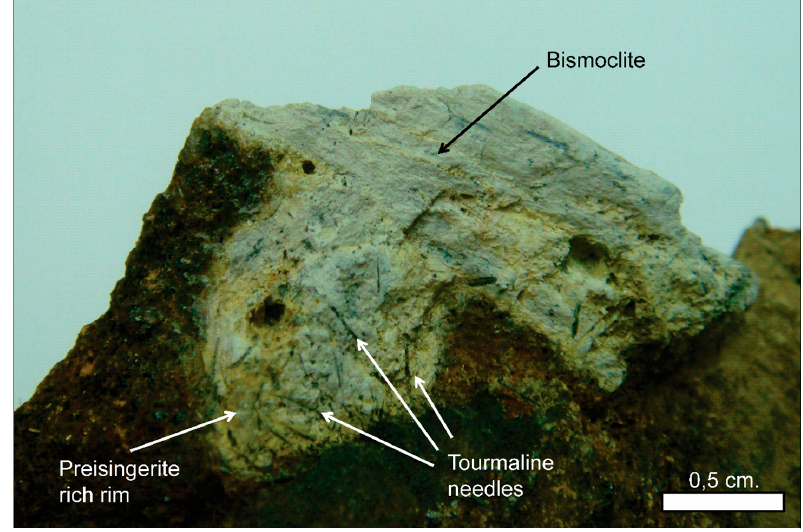
Figure 4. Bismoclite cluster with preisingerite and tourmaline needles near the margins. Sample: Figure 4.